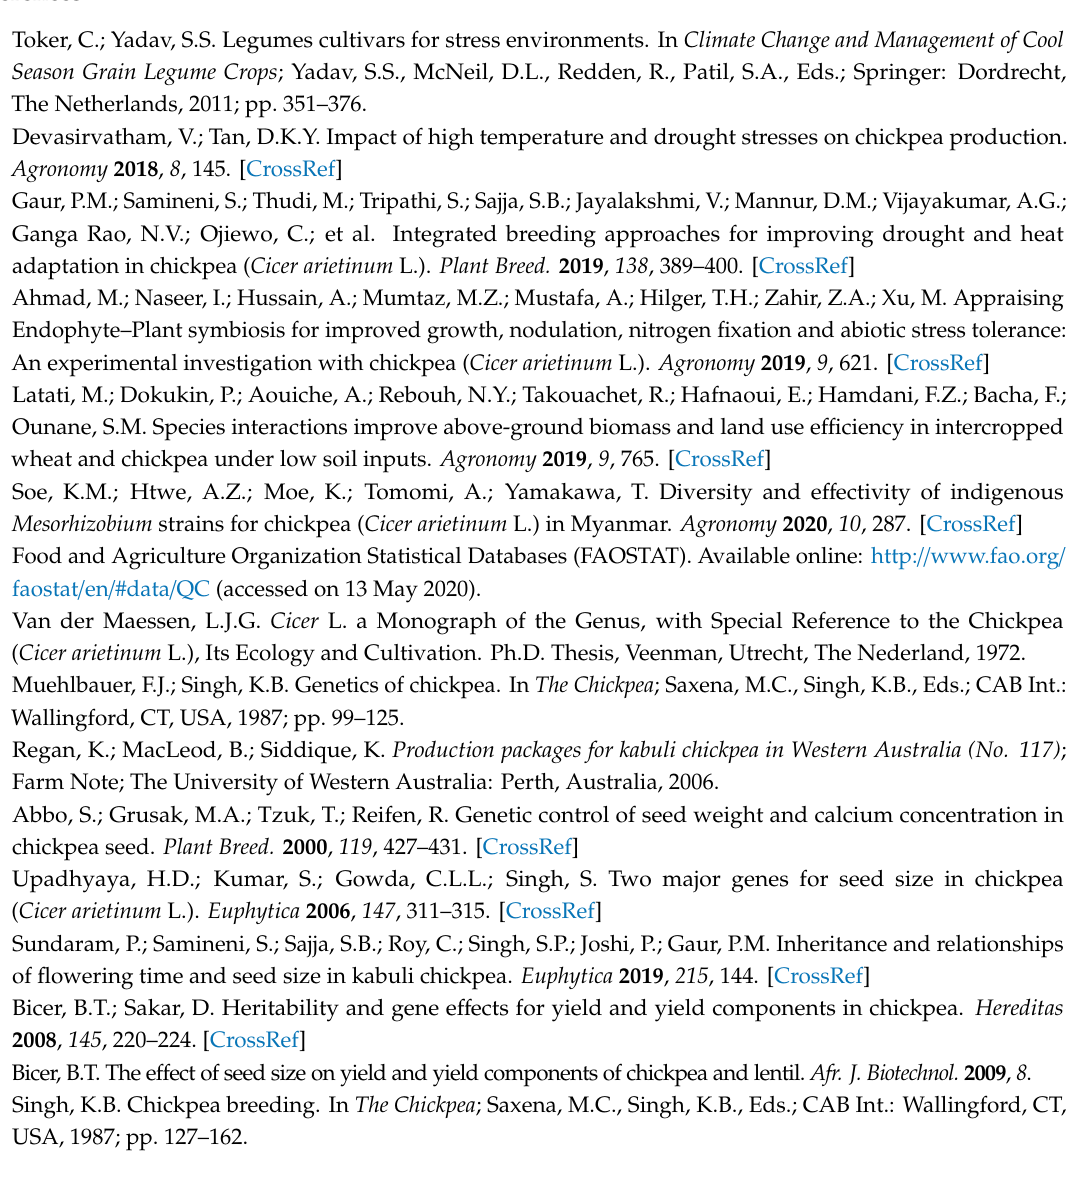
Table S1: Monthly rainfall, relative humidity and extreme maximum and minimum temperatures during progeny growing seasons from F 1 to F 3